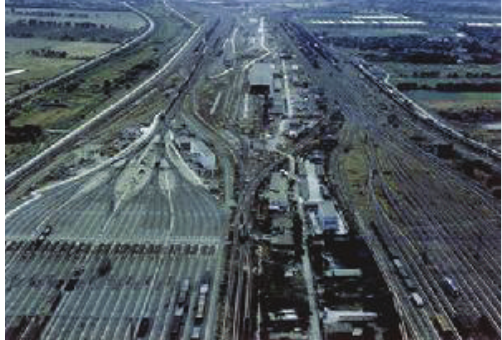
Figure 6: Marshaling station and container depot